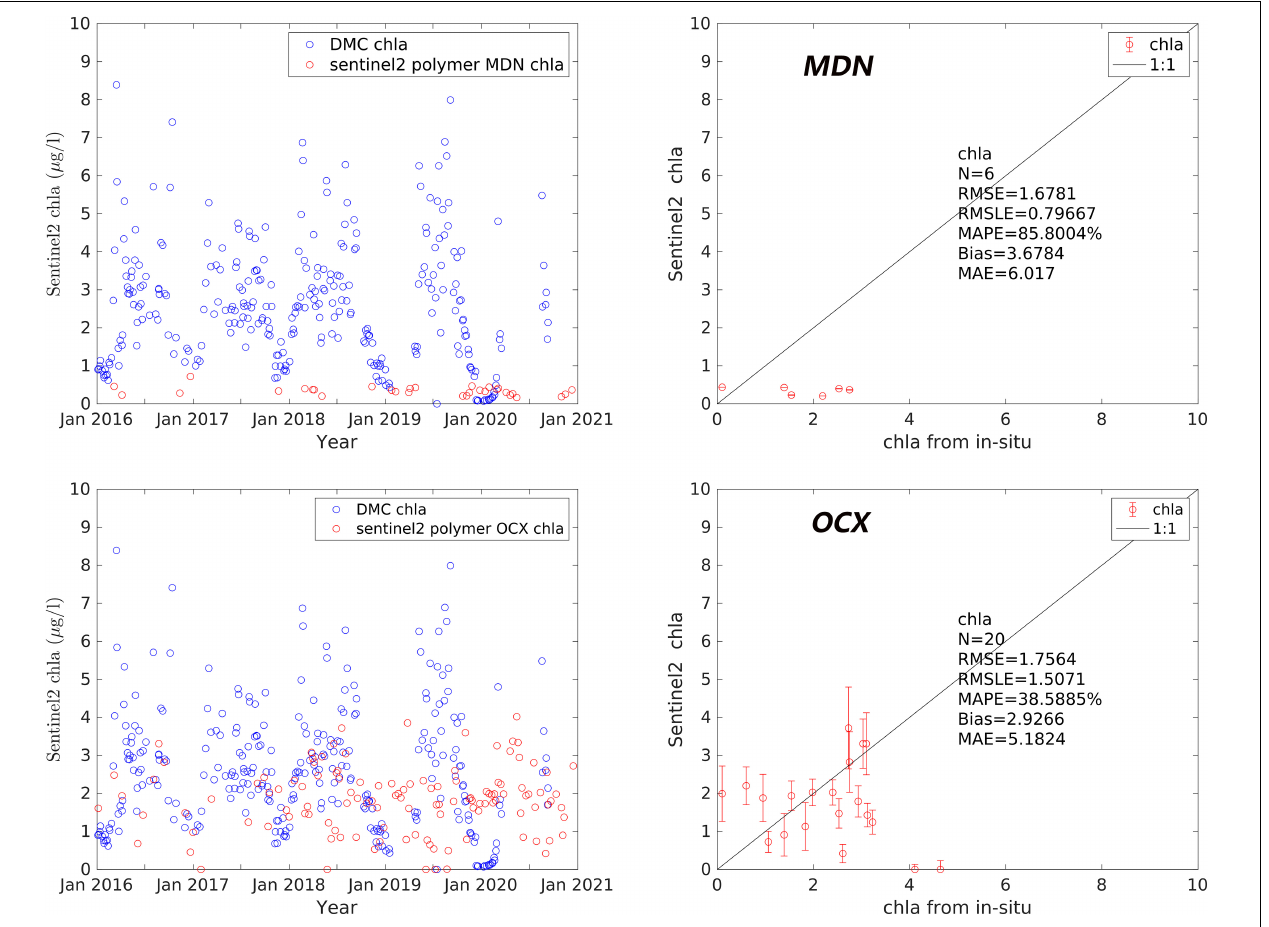
FIGURE 2 | (Left) Time series comparisons of remote sensing Chl a and extracted in-situ Chl a in the Damariscotta River estuary. (Right) Matchups between remote sensing Chl a and time series Chl a. All satellite derived Chl a was Polymer processed and Chl a was derived from the MDN (top) or OCx (bottom)